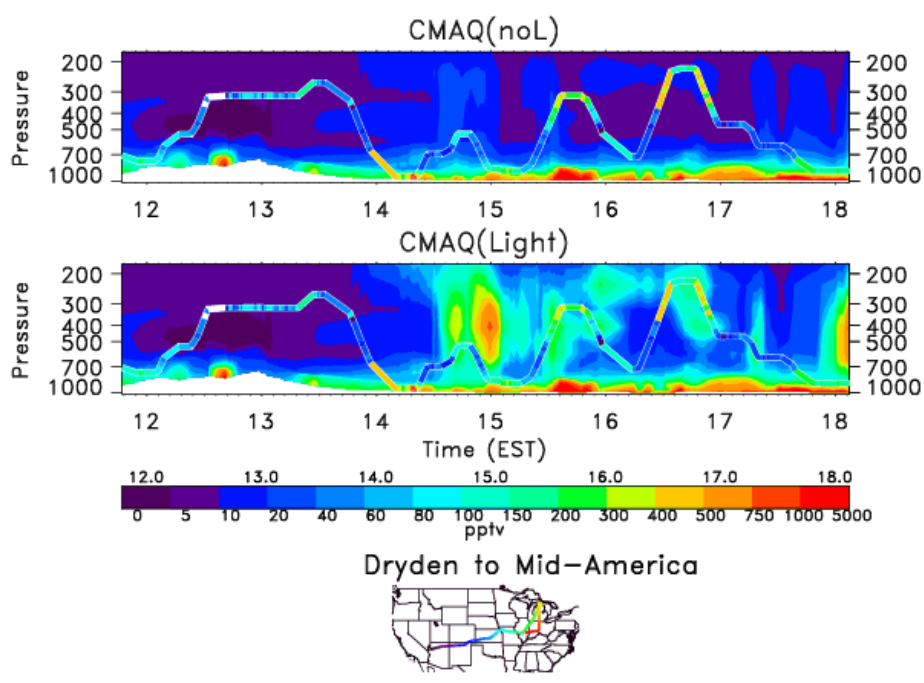
Fig. 13. Curtain plot comparing model NO 2 as a function of time (EST) and pressure (hPa) with measurements from DC-8 Flight 4 on 6 July 2004. Top (bottom) panel shows results from simulation noL (LNO x ) . Measured values are shown with a ribbon. Model values are shown in the background. The location and time of INTEX-A samples are shown on the United States map. The color bar shows the time of one-minute average samples and the scale for the NO x measurements.